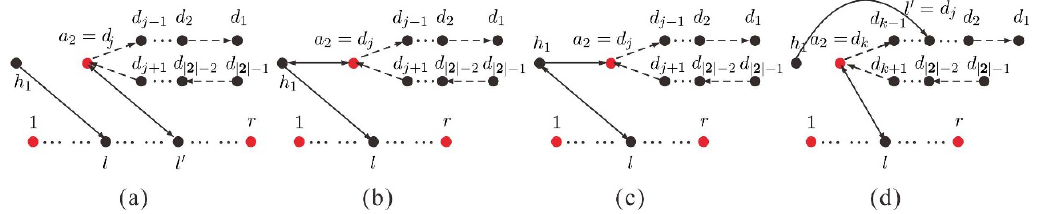
Figure 9 . Typical graphs for the identity (2.21) induced from the double-trace amplitude A (1 ; 2 ; (cid:1) (cid:1) (cid:1) ; r j 222 k h 1 ) with the reference order R = f h 1 ; 222 g . Here, gluons of the trace 222 are sup- posed to be in the cyclic order d 1 ; d 2 ; : : : ; d induced identity